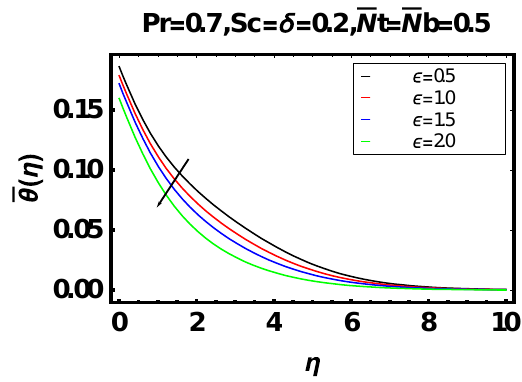
Figure 14. Temperature profile for variant ϵ .